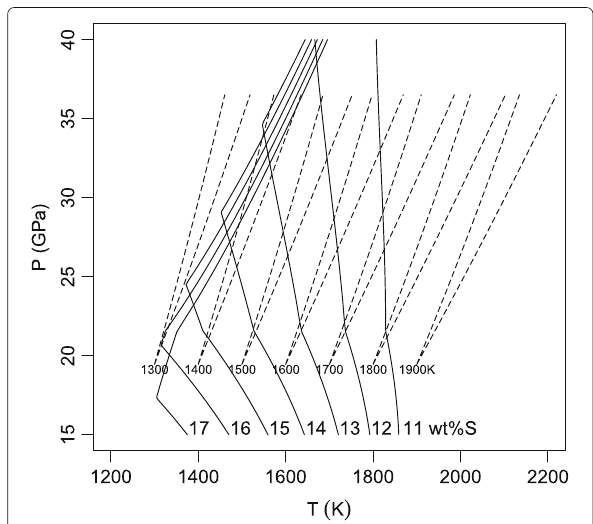
Fig. 4 Liquidus curves for a suite of fixed compositions in Mars’ core ( solidlines ; these are iso-compositional sections through Fig. 3), superimposed with various adiabatic temperature profiles initiated at the core-mantle boundary ( dashedlines ; ranges shown for 1.2 ≤ γ ≤ 1.6 for each labeled T CMB ) and extending through the core. Fe crystallizes where the liquidus curve slope is negative, whereas Fe 3 − x S 2 crystallizes if the slope is positive (Fig. 3). For T CMB < 1300 K, the core is solid, whereas if T CMB > 1450 K it is liquid. At any T CMB < 1850 K, the top of the core crystallizes an Fe ‘snow’; if, moreover, T CMB < 1450 K, the base crystallizes an Fe 3 − x S 2 “ground fog.” Adiabats calculated using d log ( T )/ dz = γ g ( r )/ V P 2 ( r ) with z the depth below the CMB using data from Rivoldini et al.